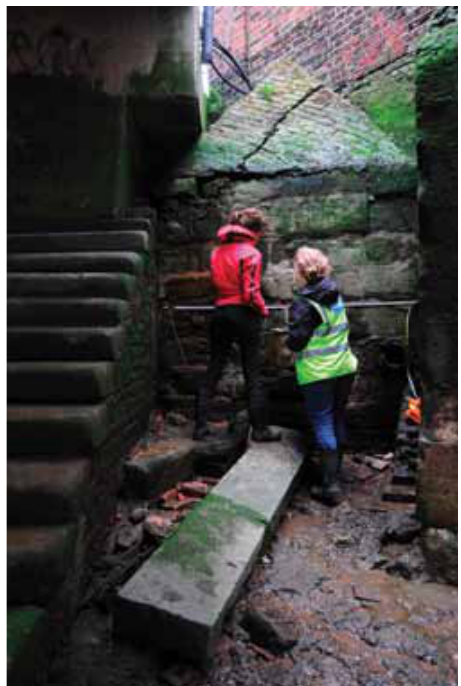
Fig 4: Recording at the Tower of London (photo P.